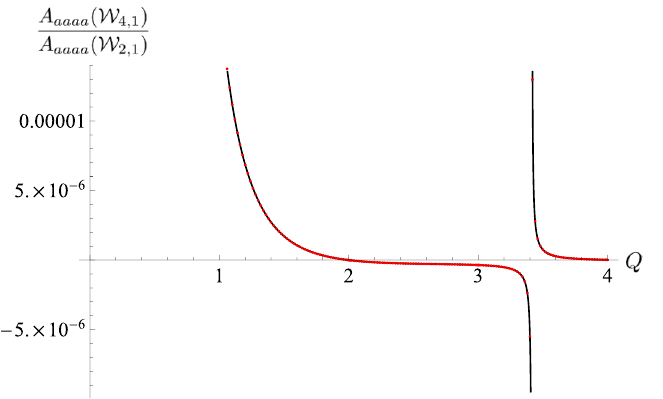
from the bootstrap result (red dots) A aaaa ( W 2 , 1 )